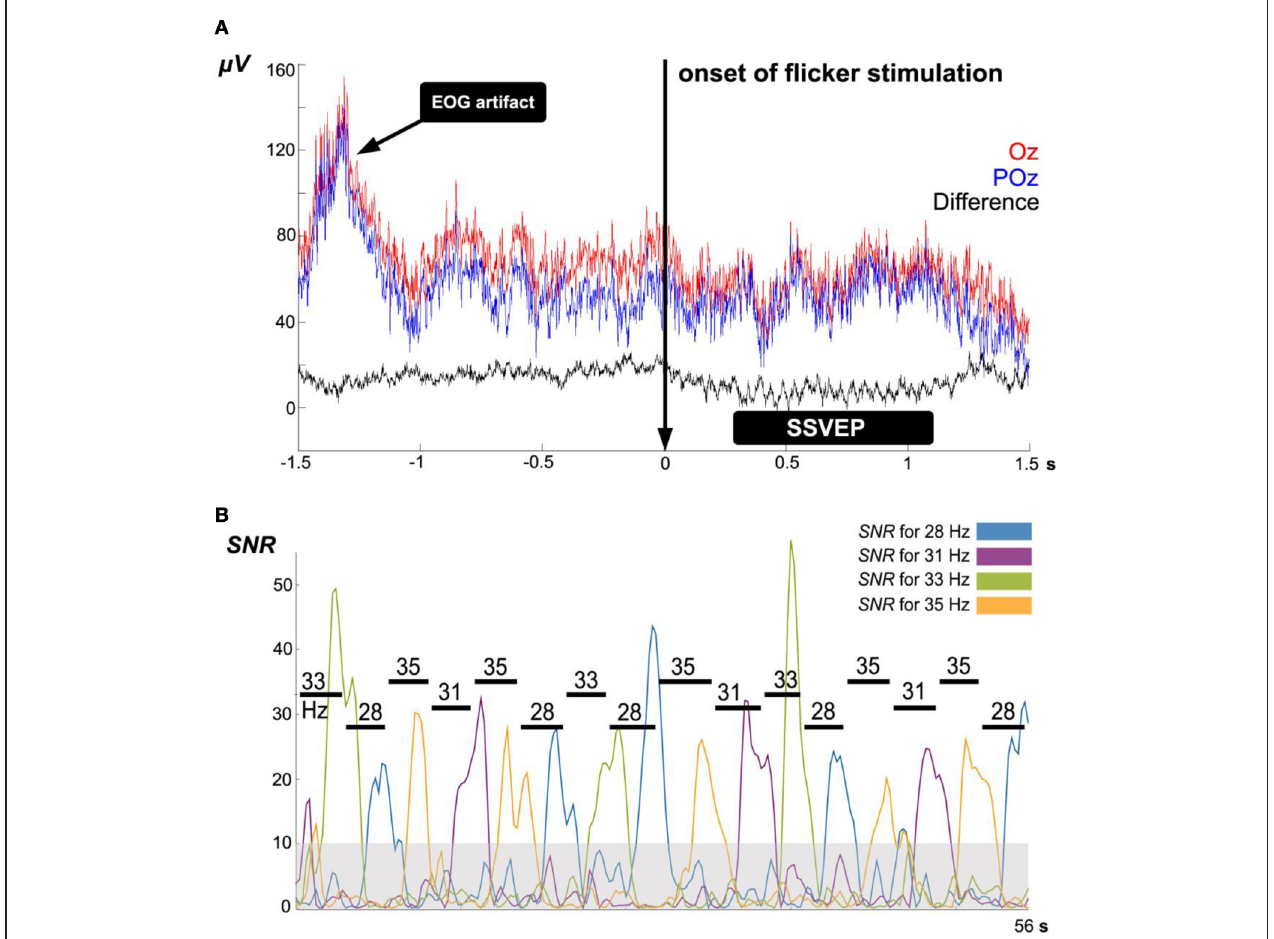
simple spatial high-pass filter. (B) Example of signal-to-noise ratios S f during a single iteration ofthealgorithm ACLusing four different flicker frequencies. The gray shadowed area represents the noise floor with dimensionless value 10; this level was defined as SSVEPdetection threshold for all subjects. Horizontal lines indicate the detection duration of each target frequency at each